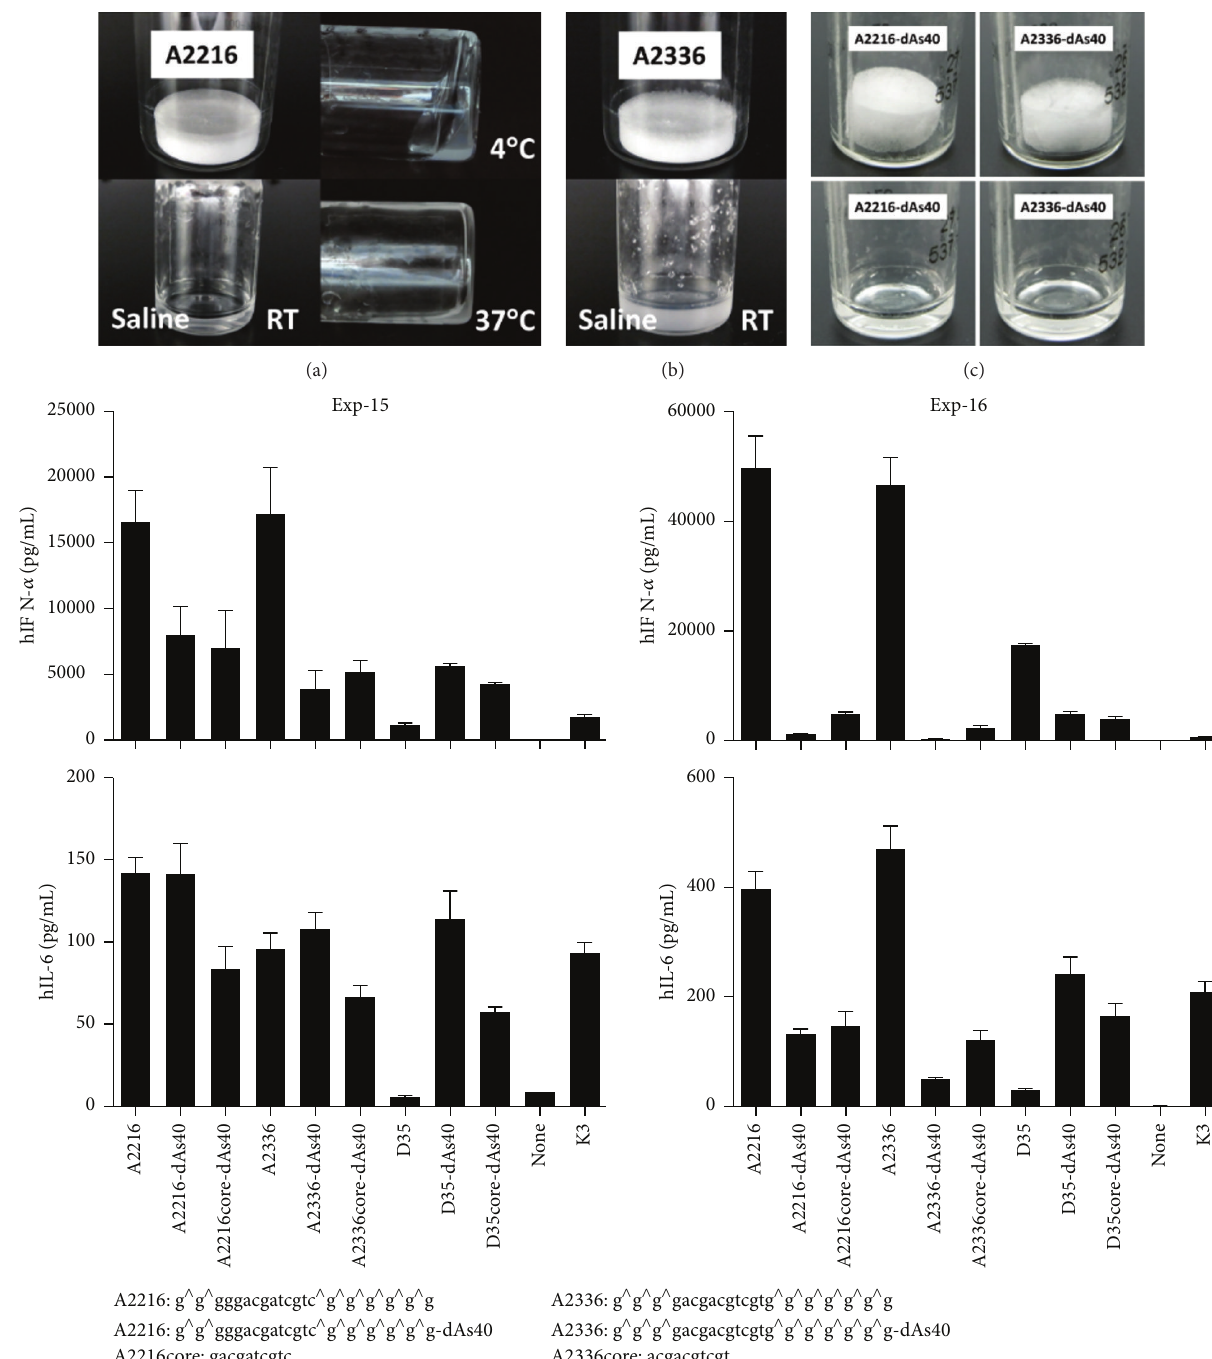
Figure 9: 3 󸀠 addition of dAs40 sequence to A2216 and A2336 improves direct solubilization in saline. (a) Lyophilized A2216 vial (10mg/vial) (upper left) was completely solubilized with 1mL of saline directly at room temperature (RT) (lower left). The solution turned to a gel at 4 ∘ C (upper right) and reliquefied at 37 ∘ C (lower right). (b) Lyophilized A2336 vial (10mg/vial) (upper) formed many visible gelatinous aggregation with 1mL of saline at RT (lower). (c) Lyophilized A2216-dAs40 (0.5mg/vial) and A2336-dAs40 (0.5 mg/vial) were easily and completely dissolved with 50 𝜇 L of saline at RT. (d) Human PBMCs were stimulated with the indicated synthetic ODNs (1 𝜇 M) for 24 hours. IFN- 𝛼 and IL-6 production in the supernatants were examined by ELISA. Bar indicates the mean ±